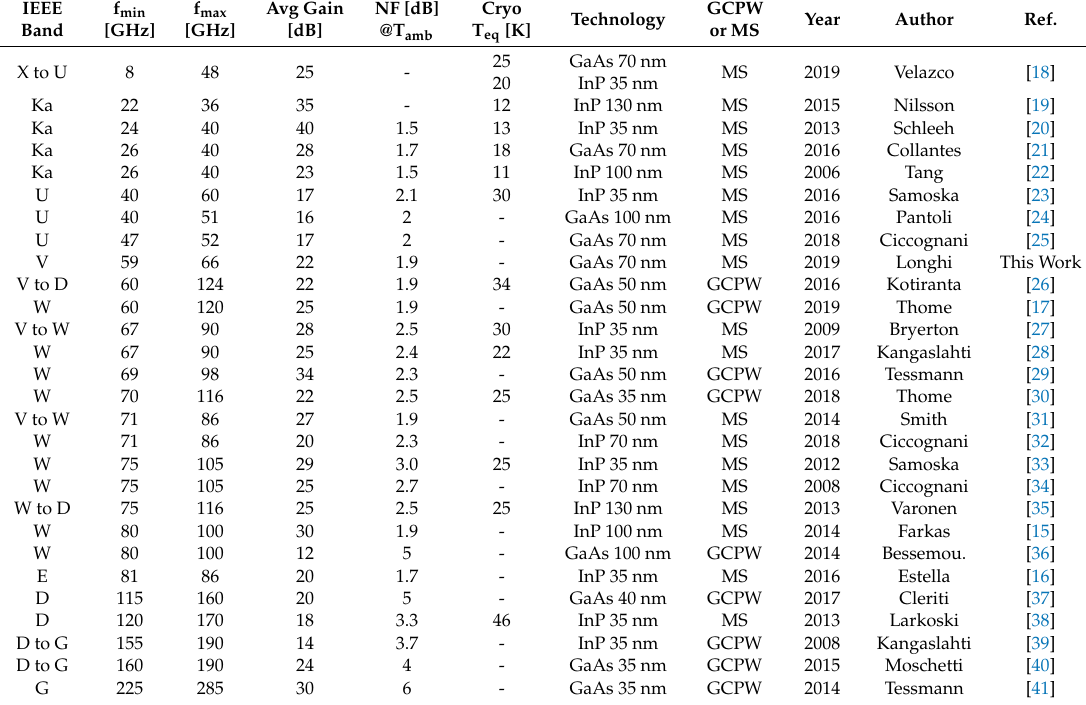
Table 2. Performance summary of published LNA works.